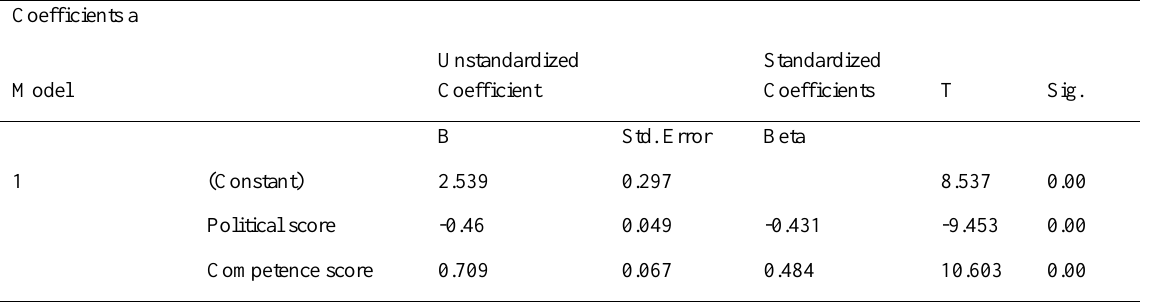
Table 6: Regression Model